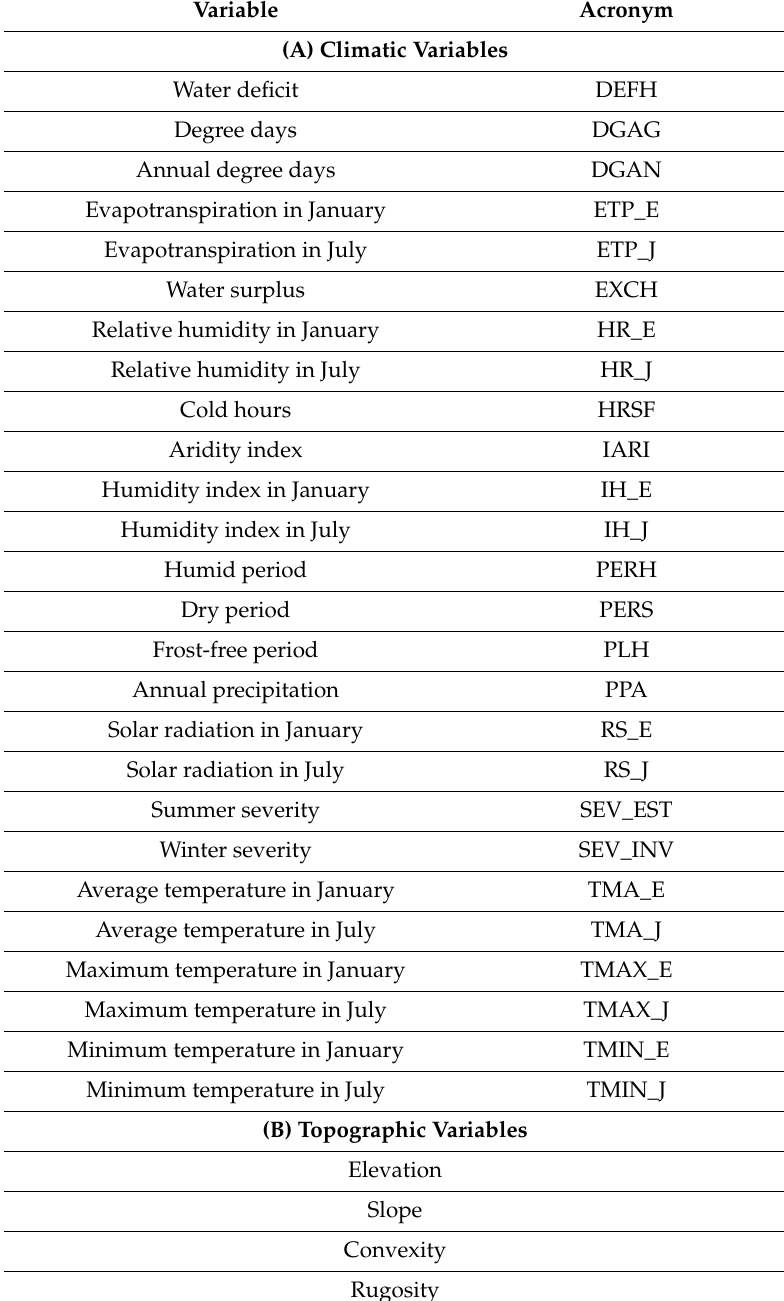
Table 1. Climatic and topographic variables used in the Topoclimatic zoning of the Atacama region.